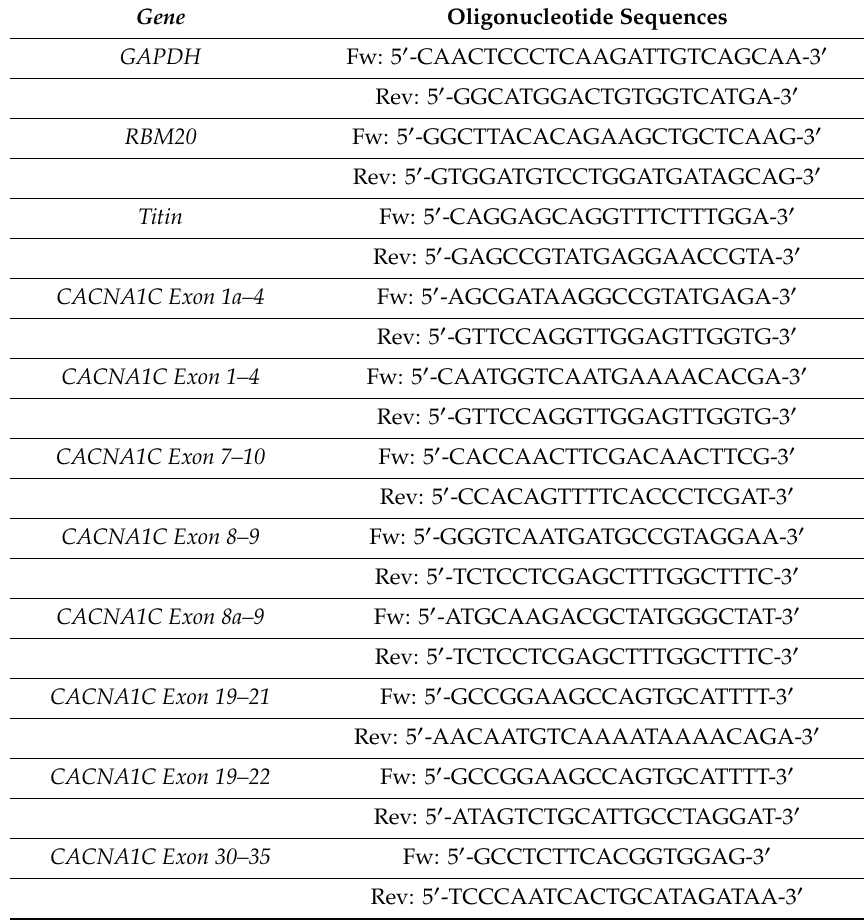
Table 1. Primers used in real-time quantitative PCR and RT-PCR. The table shows the sequences of the primer pairs used for the real-time quantitative PCR and RT-PCR experiments in the present study. Fw: Forward primer; Rev: Reverse primer. Gene Oligonucleotide Sequences